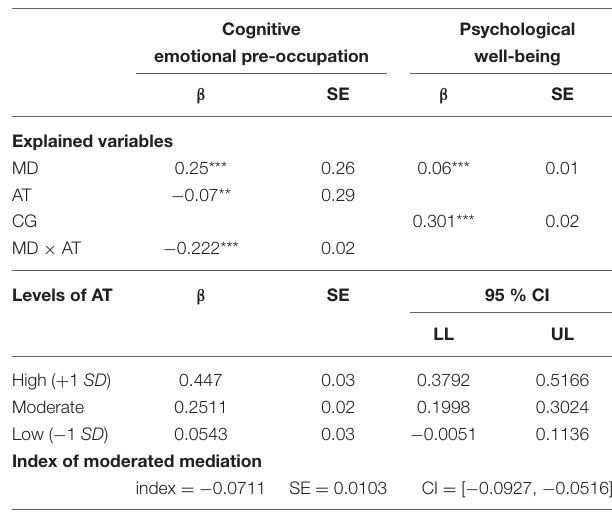
TABLE 5 | Moderated mediation model of attention control, mobile phone distraction, cognitive emotional pre-occupation, and psychological well-being (model 7 process macro, n = 914).